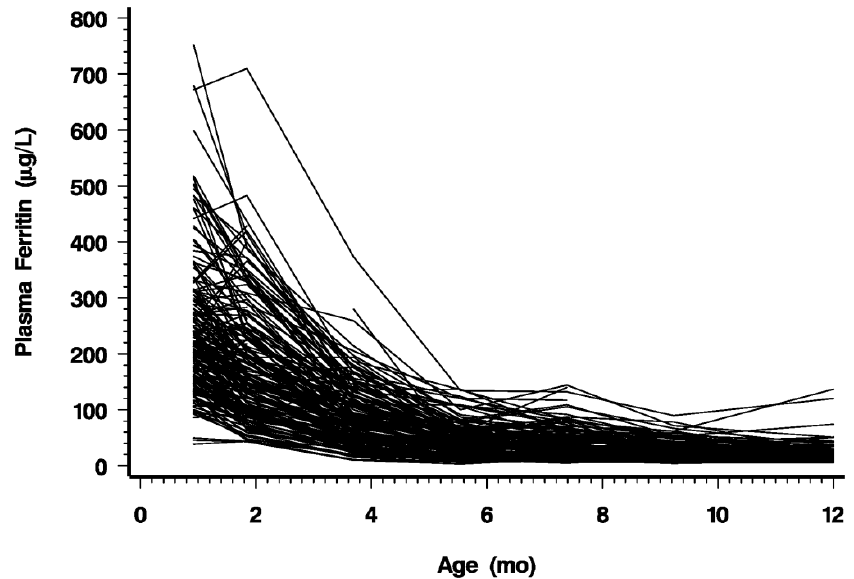
Figure 3. PF of individual infants from 1 to 12